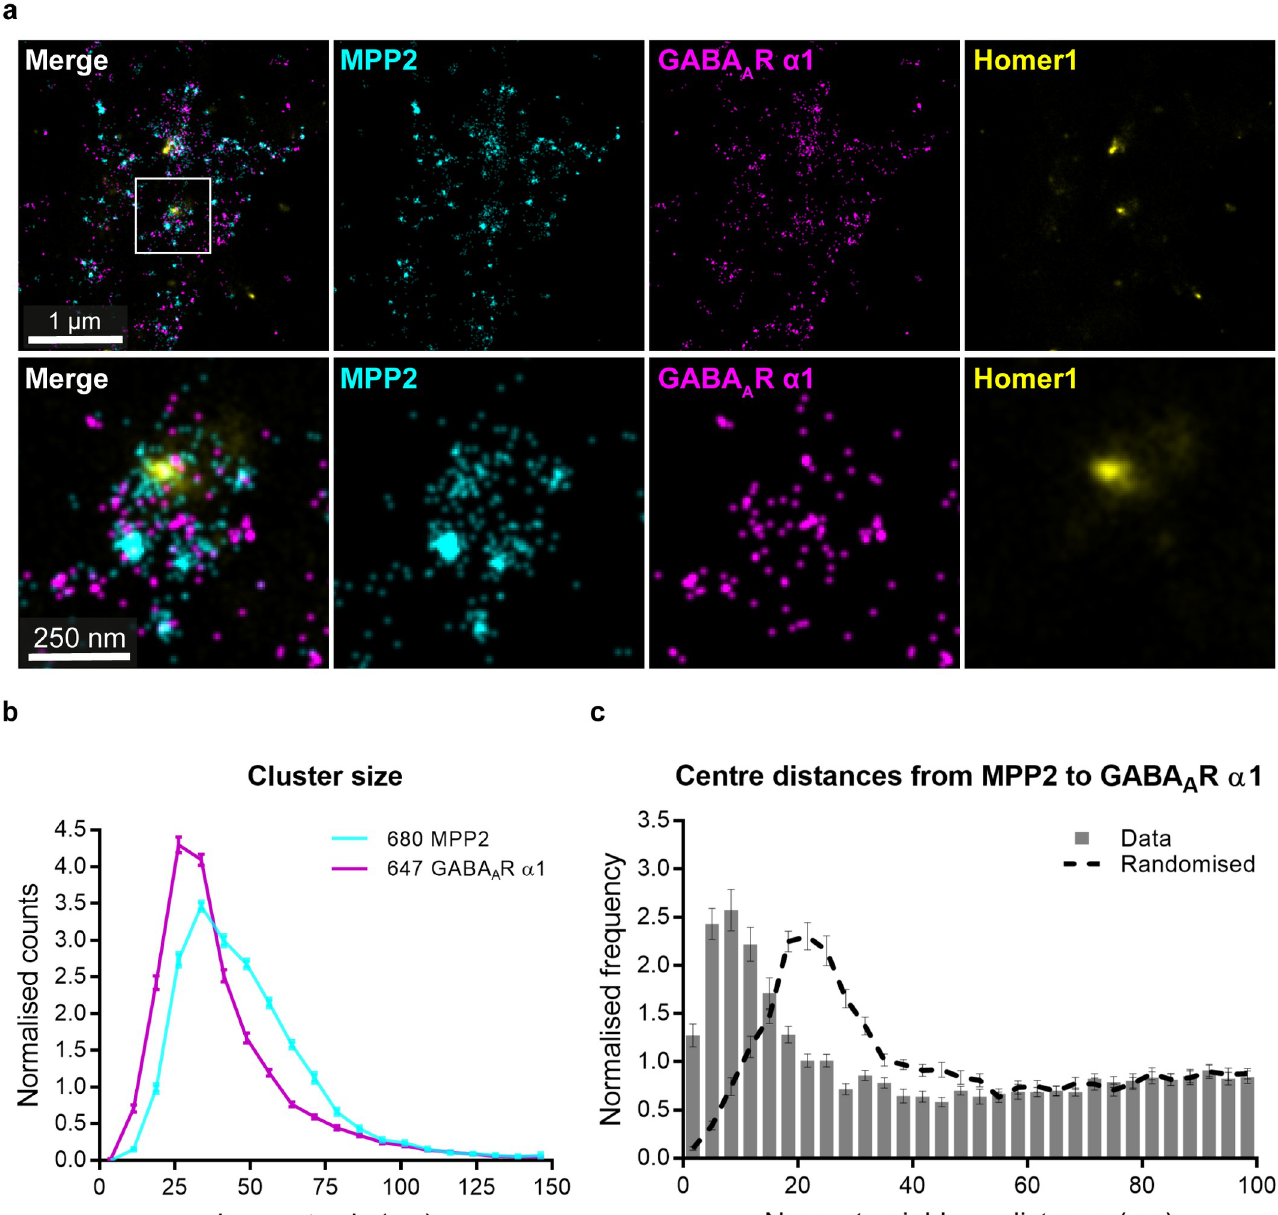
Fig 8. MPP2 and GABA A R α 1 form highly overlapping nanoclusters. Mature (DIV21) primary rat hippocampal neurons were immunostained for endogenous MPP2 (cyan, second column), GABA A R α 1 (magenta, third column), and the PSD marker Homer1 (yellow, fourth column) and subjected to triple- colour d STORM imaging. (a) Overview of a dendritic segment (upper row). White box indicates location of detail image below. Zooming onto an individual synapse expressing Homer1, MPP2, and GABA A R α 1 (lower row) reveals a close association between clusters of MPP2 and GABA A R α 1 and the bracelet-like arrangements of MPP2 surrounding a centrally positioned Homer1 cluster. Scale bars: overview 1 μ m; detail 250 nm. (b) Histograms illustrating the distribution of nano-cluster sizes (longest axis) for MPP2 (cyan) and GABA A R α 1 (magenta). Clusters were detected via DBSCAN. Mean ± SEM; n = 26 images from N = 3 independent experiments. (c) NN analysis of MPP2 and GABA A R α 1 protein clusters after DBSCAN. NN distances were calculated from the cluster centres. Closest GABA A R α 1 to MPP2 were analysed (grey bars). Dashed lines represent the random control by toroidal shift. Note the close association of both clusters (approximately 10 nm distance between both centres), which is well below the cluster sizes (20 to 40 and 30 to 60 nm, see b) and shifted after randomisation. Mean ± SEM; n = 26 images from N = 3 independent experiments. Please see S8 Fig for related analysis in the reverse direction. Underlying data can be found in S2 Data. DIV, days in vitro; d STORM, direct stochastic optical reconstruction microscopy; GABA, γ -aminobutyric acid; MPP2, membrane protein palmitoylated 2; NN, nearest neighbour; PSD, postsynaptic